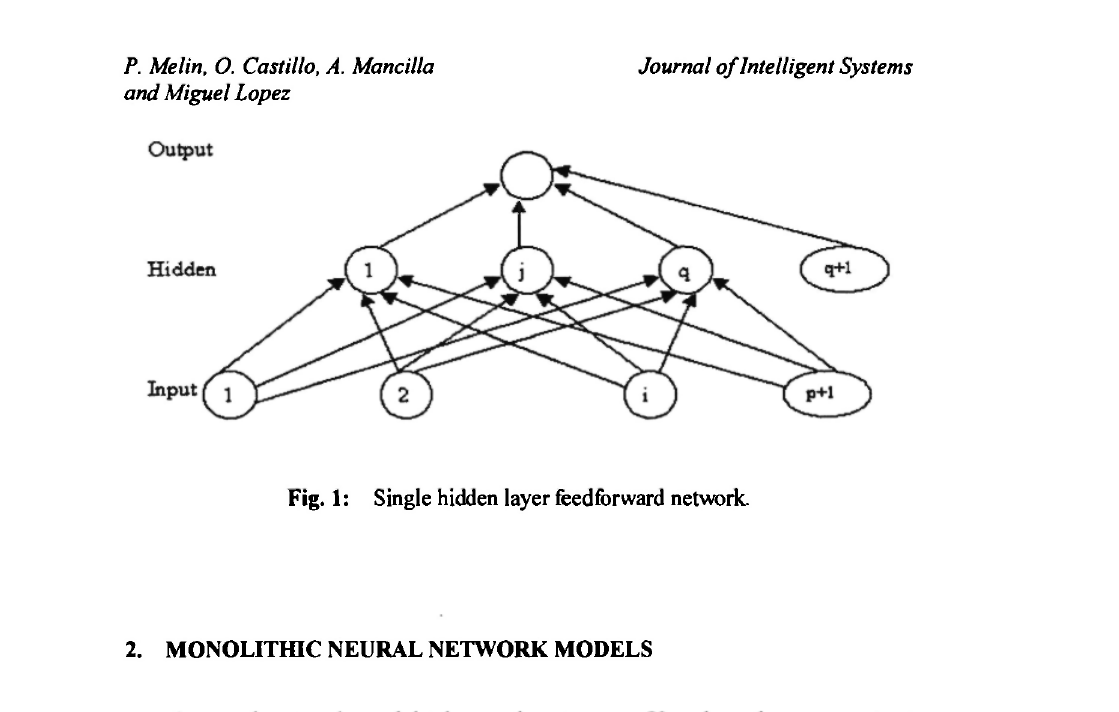
Fig. 1: Single hidden layer feedforward